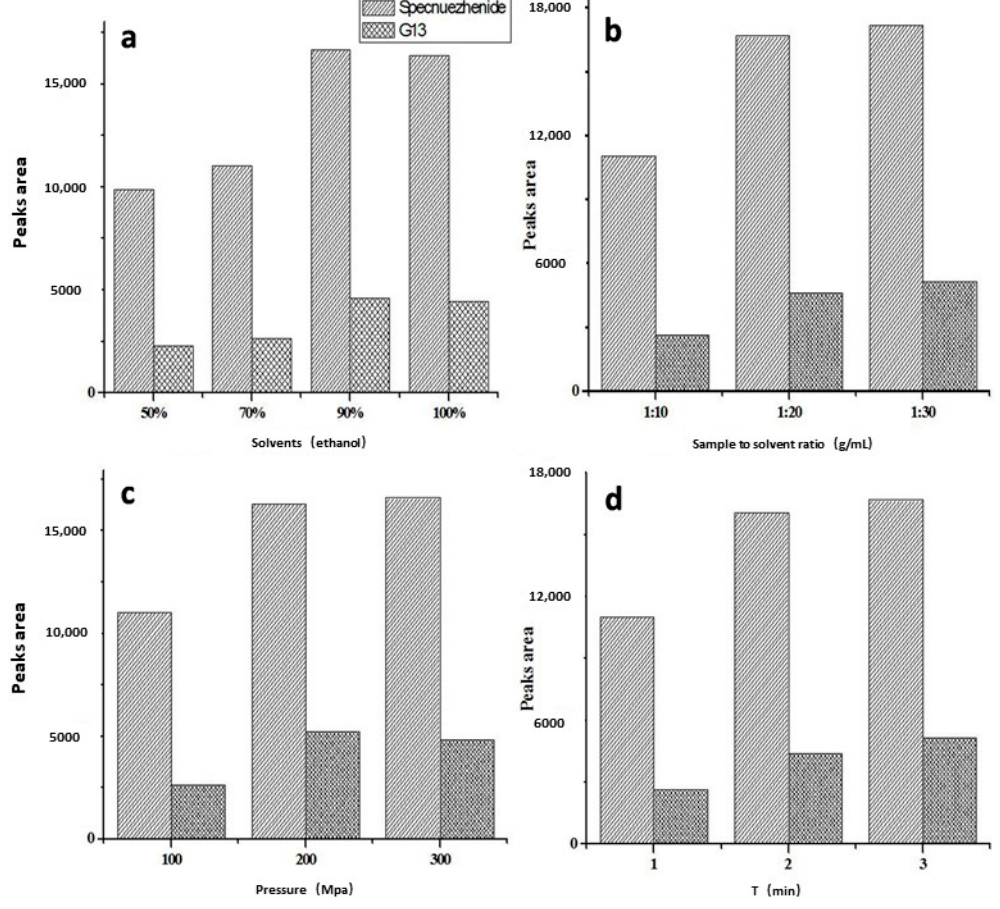
Figure 2. Effects of solvents ( a ), sample to solvent ratio (g/mL) ( b ), pressure ( c ) and extraction time ( d ) on the changes in nuezhenoside G13 ( 4 ) and specnuezhenide ( 5 ) contents by UPE.